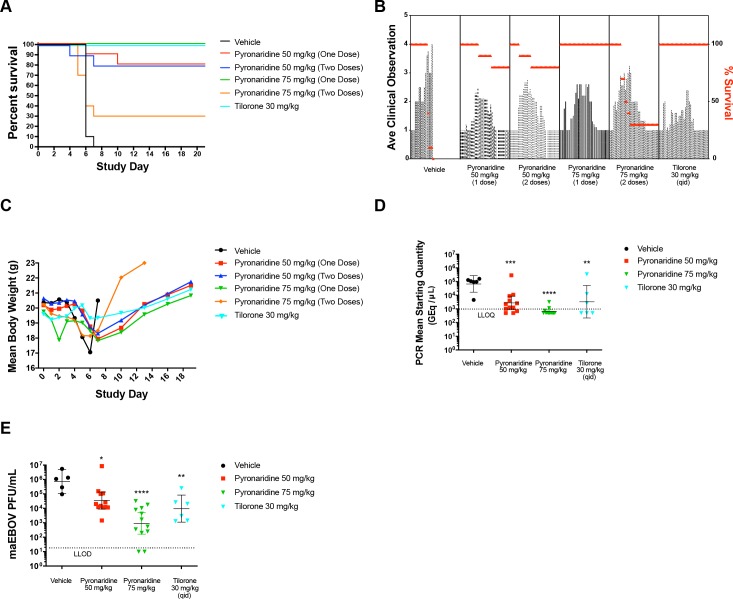
maEBOV efficacy data.(A) The survival curves between pyronaridine 50 mg/kg (1 or 2 doses), pyronaridine 75 mg/kg (1 dose) and tilorone 30 mg/kg were not statistically significantly different using a log-rank (Mantel-Cox) test (p = 0.2268). (B) Mean clinical scoring results with overlaid percent survival. (C) Mean body weight results. (D) qRT-PCR measurement of viral RNA in sera (mice sacrificed on SD3). Dunnett’s test, **, Adjusted p = 0.0071, ***; Adjusted p = 0.0010, ****, Adjusted p < 0.0001, (E) Plaque assay for viable EBOV in sera (mice sacrificed on SD3) (Dunnett’s test: control vs pyronaridine 50 mg/kg, Adjusted P = 0.0424 (*); control vs pyronaridine 75 mg/kg, Adjusted P < 0.0001; control vs tilorone 30 mg/kg, Adjusted P = 0.0094 (**)). Statistical significance was calculated with log-transformed qPCR and plaque assay data using a Dunnett’s test with the vehicle designated as the control. PCR mean starting quantity and maEBOV viral load had LLOD/LLOQ of 1000 GEq/μl and 20 PFU/ml, respectively. Quantified values below these where set to 0.5 x LLOD/LLOQ. Bars and error-bars represents the geometric mean and 95% CI, respectively.